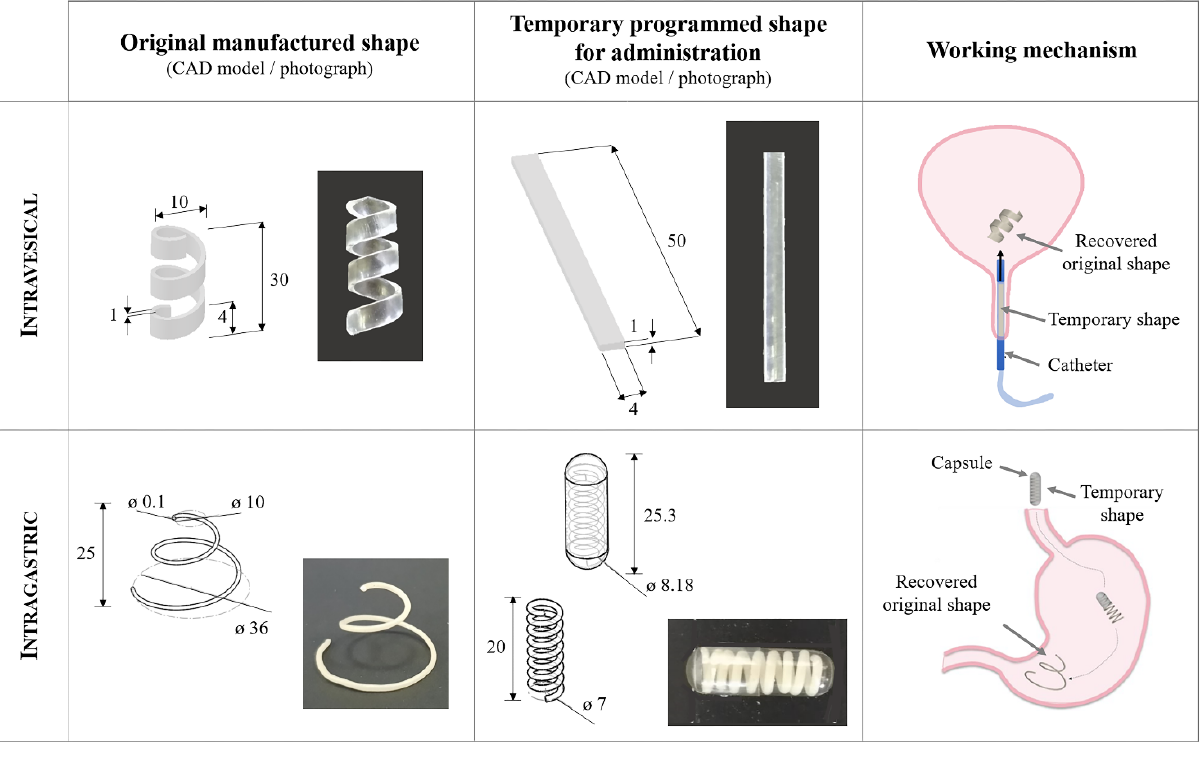
Figure 1. Design concept of expandable DDSs based on SMPs intended for retention in hollow muscular organs (dimensions are in mm).